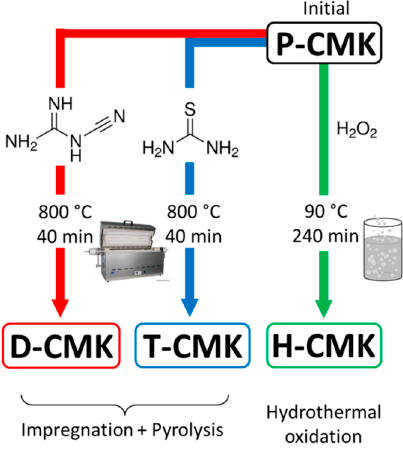
Figure 1. Scheme presenting three modification protocols used in this work.